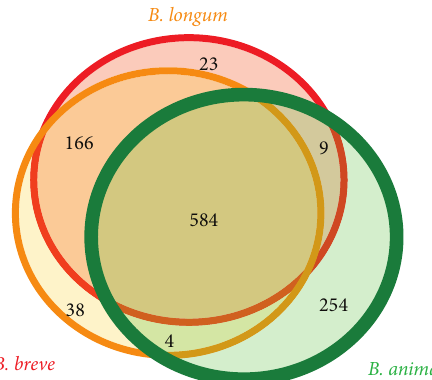
Figure 1: Venn diagram of the homologous clusters shared among the core genes. The surfaces are approximately proportional to the number of